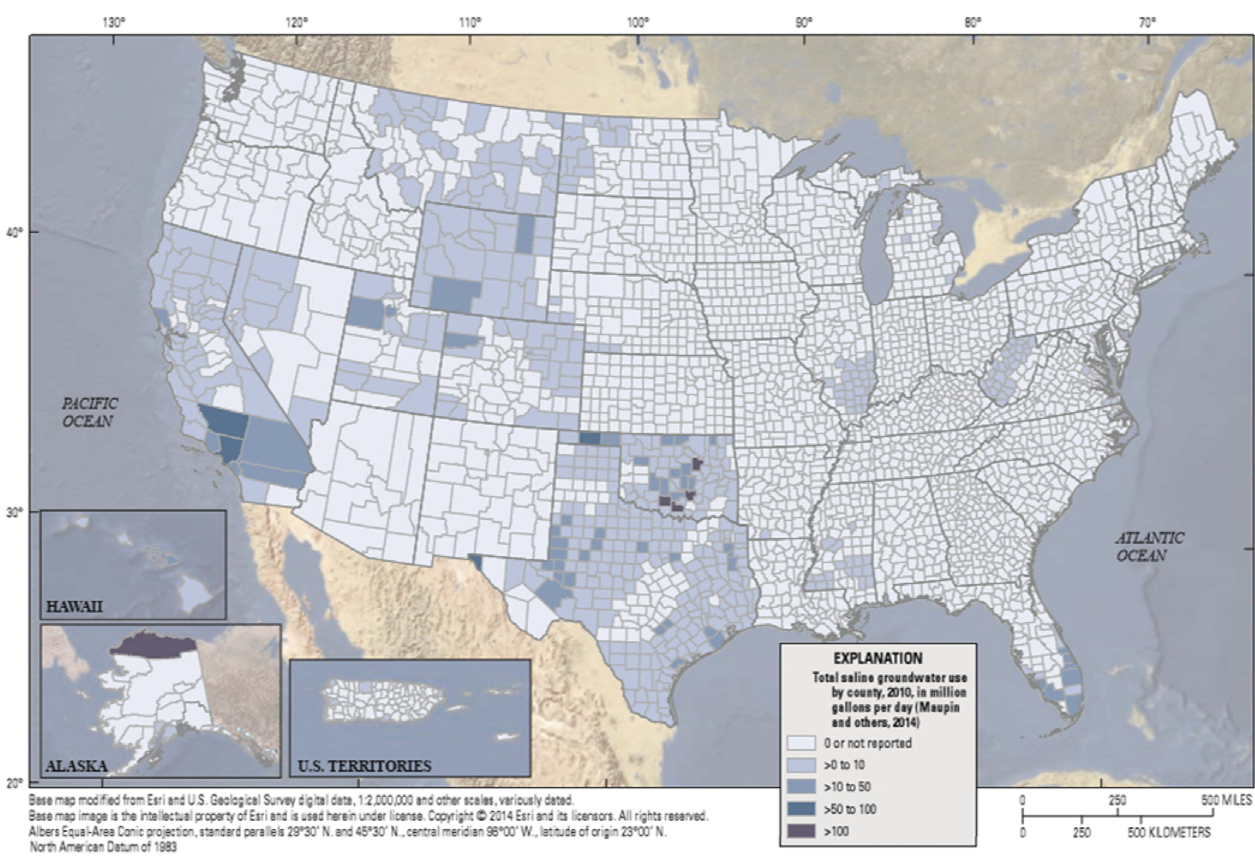
Figure 1. Total saline groundwater use in the United States by county in 2014 [23].